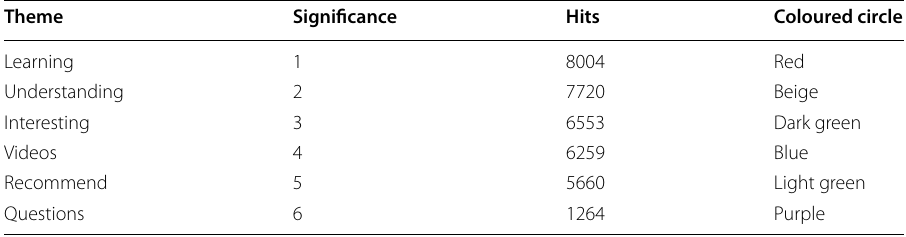
Table 4 Themes in the order of importance